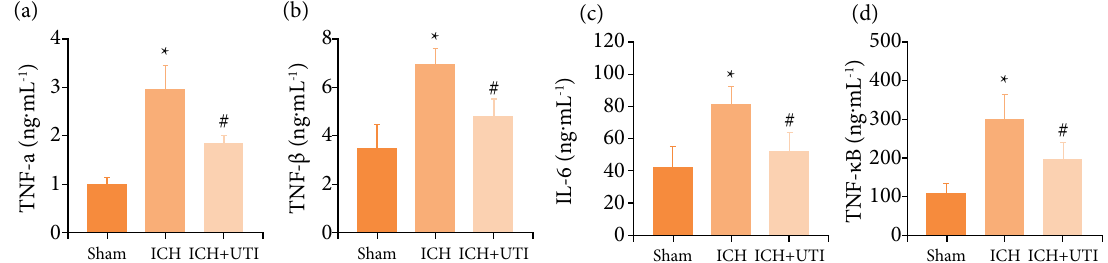
TNF- α , and the subsequent activation of proinflammatory signaling through NF- κ B to initiate pyroptosis. Therefore, the hippocampal levels of IL-1 β , IL-6, TNF- α , and NF- κ B were measured using ELISAs. The levels of the proinflammatory cytokines were increased significantly after ICH, while the levels of proinflammatory cytokines decreased significantly after